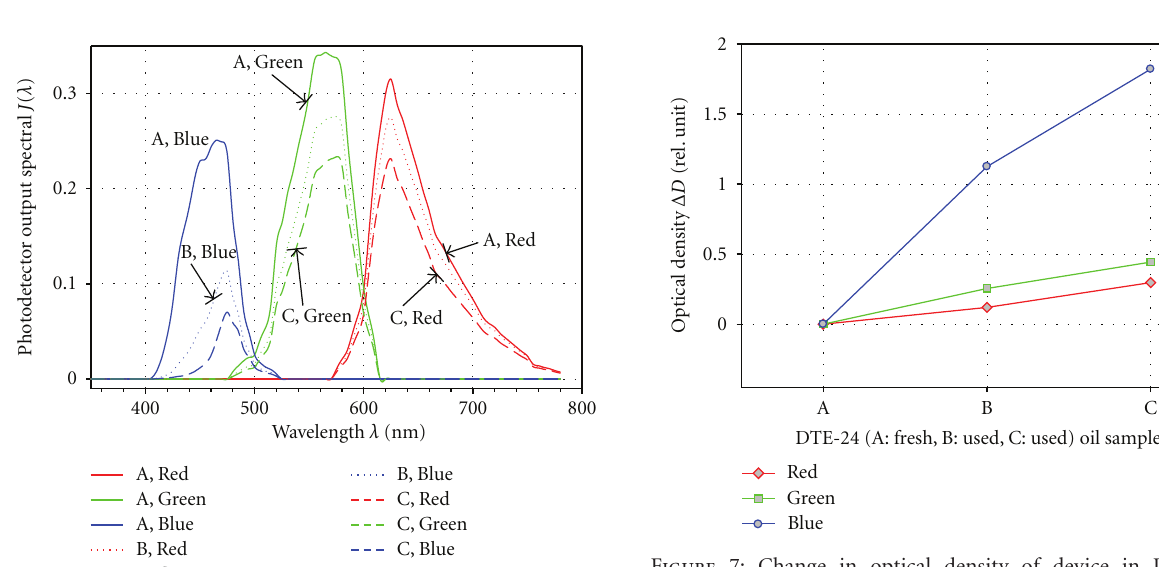
Figure 4: E ff ective spectral intensity and transmittance spectra of DTE24 #1 calibration oil.